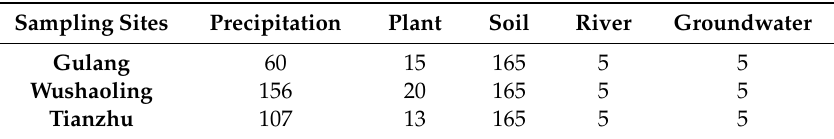
Table 2. Number of samples collected in the Qilian Mountains from 2015 to 2016. Sampling